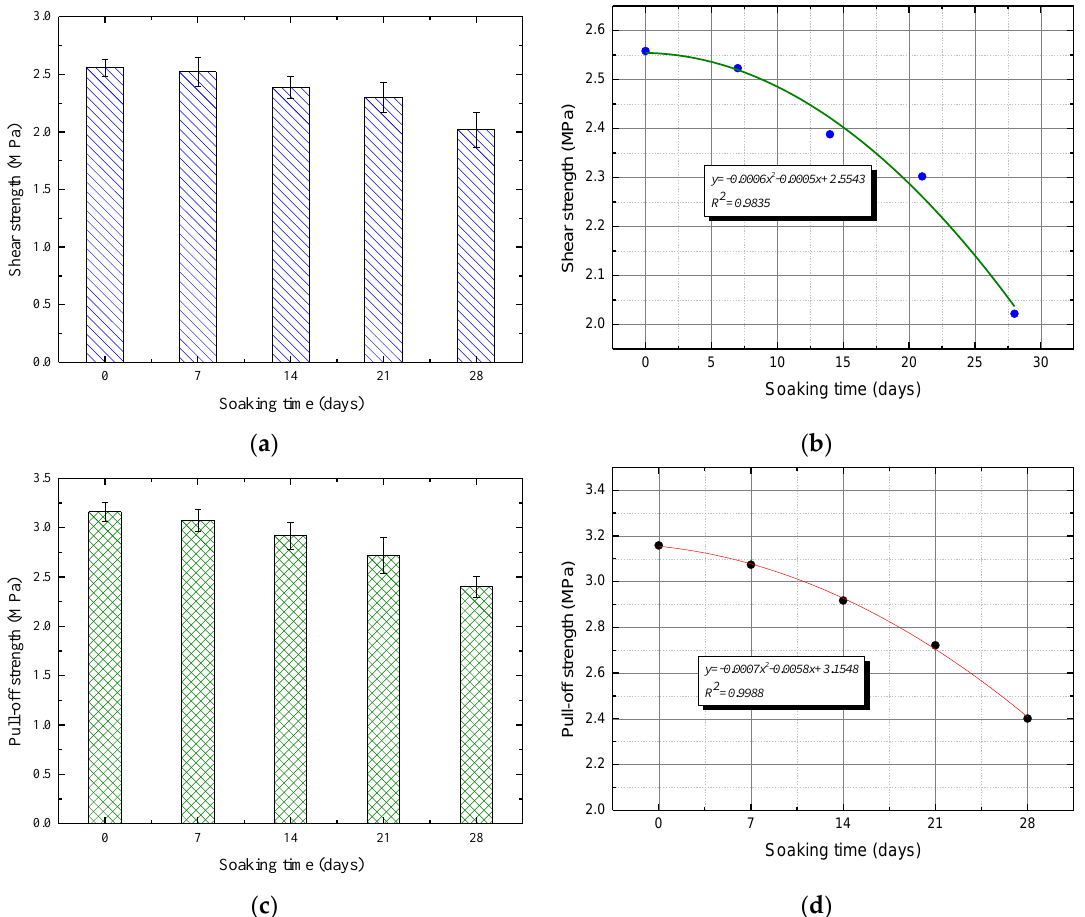
Figure 12. Effect of hot and humid environment on strength: ( a ) Changes in shear strength, ( b ) fitting of shear strength and soaking time, ( c ) changes of pull-off strength, and ( d ) fitting of pull-off strength and soaking time.